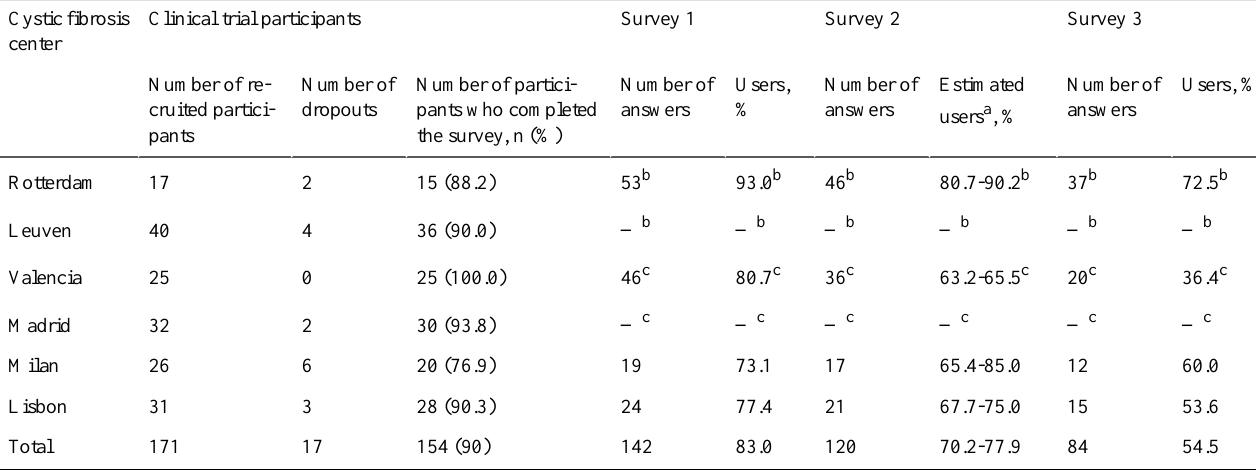
Table 2. Response rates for the